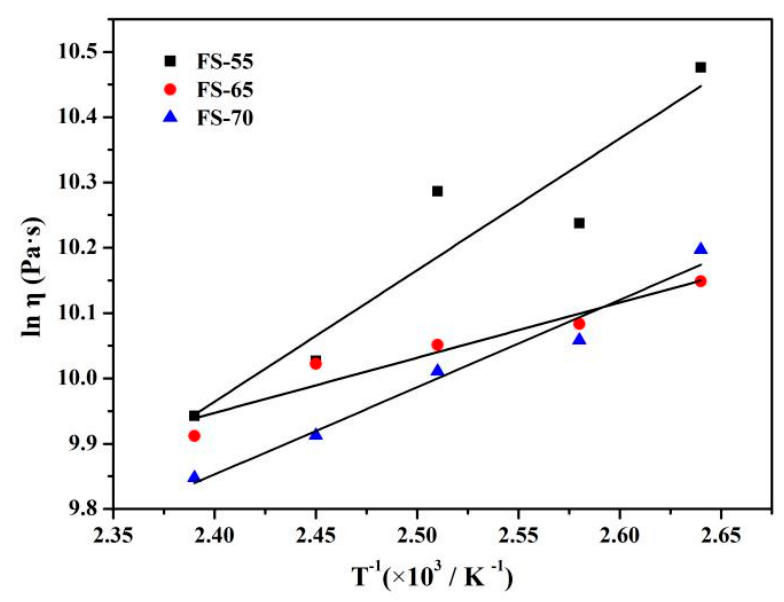
Figure 5. Relationship between viscosity and inverse temperature.